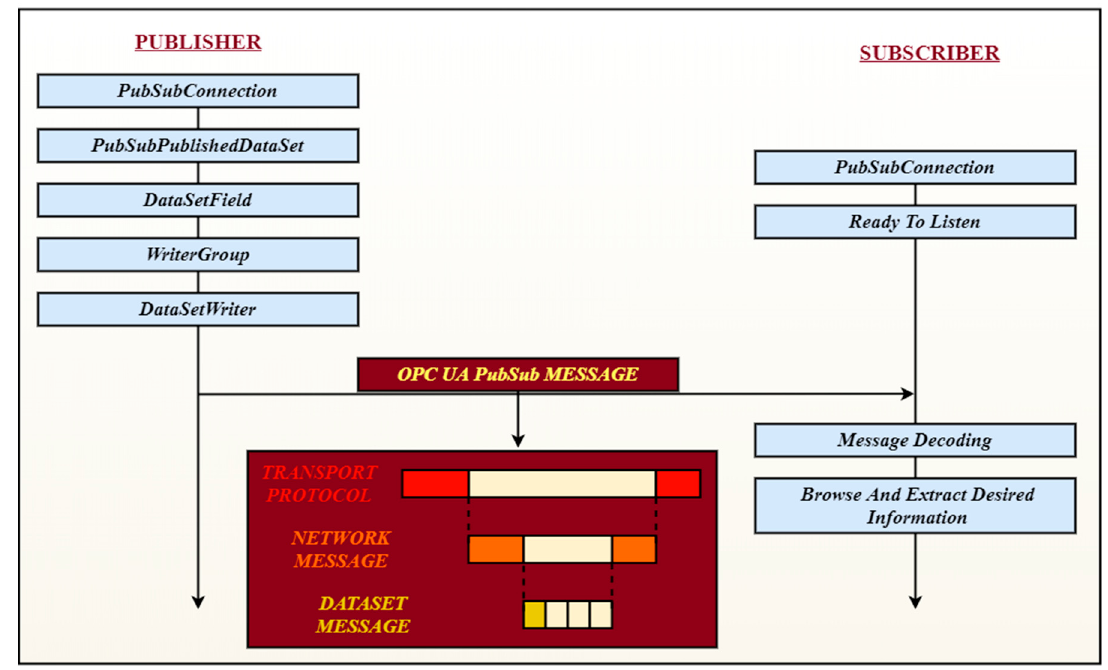
Figure 4. OPC UA Publish-Subscribe configuration components.